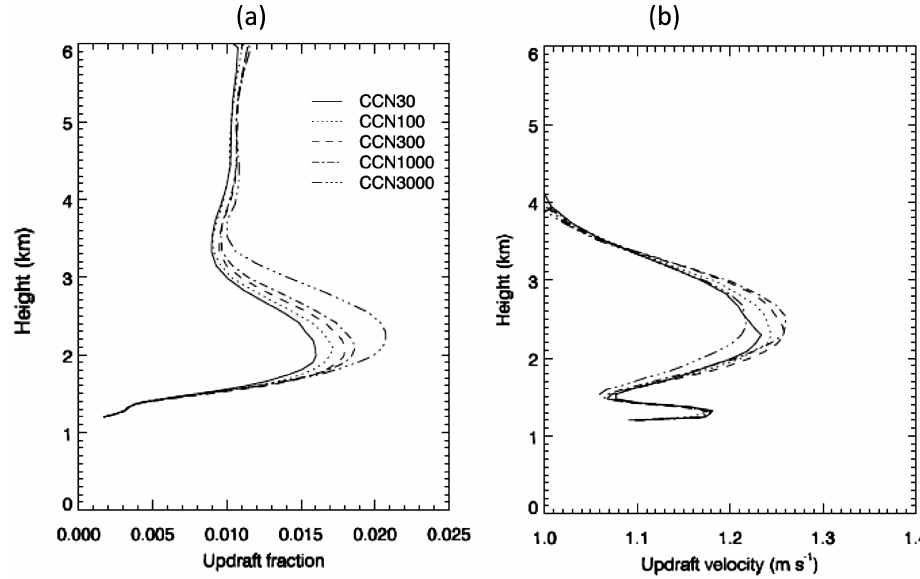
Figure 7. (a) The fraction of updraft grid points with vertical velocity larger than 1ms − 1 relative to the total domain grid points and (b) the